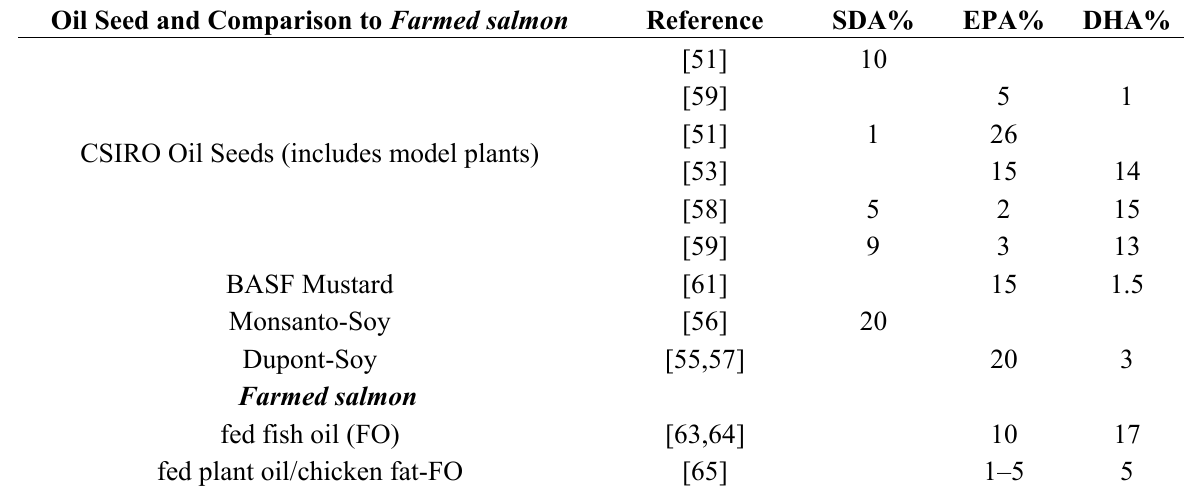
Table 2. Levels of SDA, EPA and DHA (as % of fatty acids) in new land plant oil seeds. Oil Seed and Comparison to Farmed salmon Reference SDA% EPA% DHA% [51] 10 [59] 5 1 [51] 1 26 CSIRO Oil Seeds (includes model plants) [53] 15 14 [58] 5 2 15 [59] 9 3 13 BASF Mustard [61] 15 1.5 Monsanto-Soy [56] 20 Dupont-Soy [55,57] 20 3 Farmed salmon fed fish oil (FO) [63,64] 10 17 fed plant oil/chicken fat-FO [65] 1–5